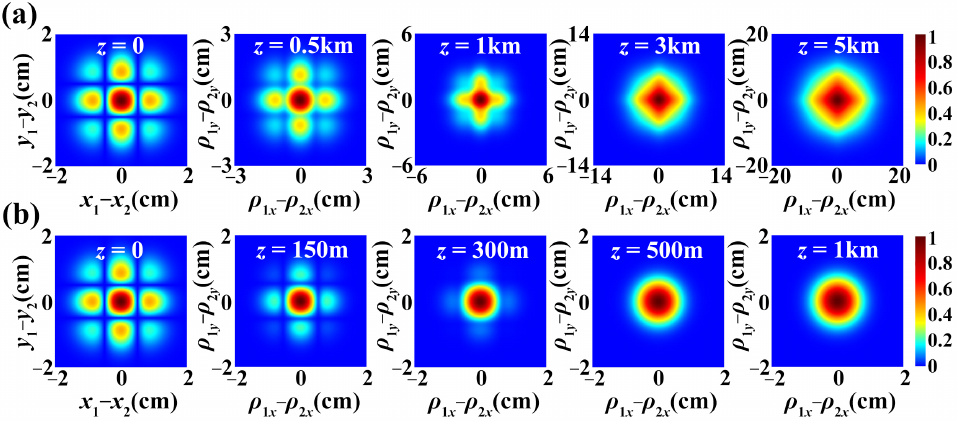
Figure 1. Evolution of the SDOC modulus of an SSS beam when traversing through ( a ) free space and ( b ) oceanic